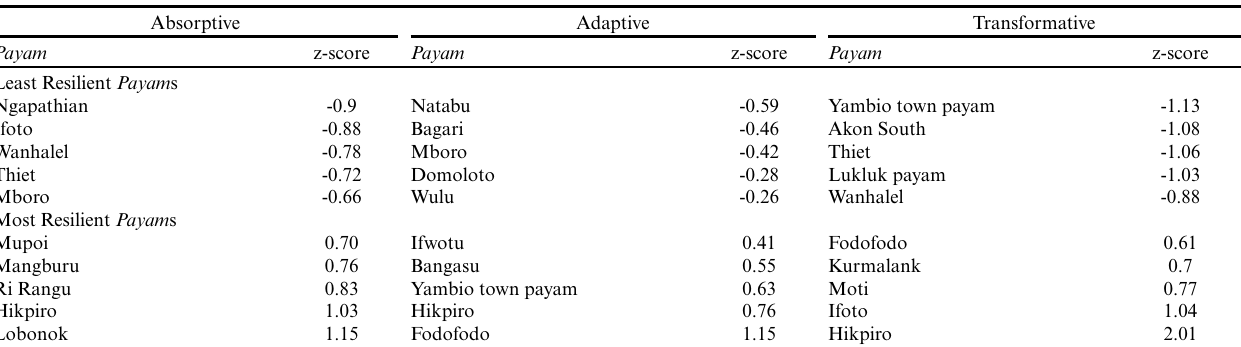
Table 5 . The five least and most resilient payams in three resilience categories; Fortifying Equality and Economic Diversification (FEED) Project, South Sudan dataset, 2015. † A payam is a subcounty unit of at least 25,000 population. Absorptive Adaptive Transformative